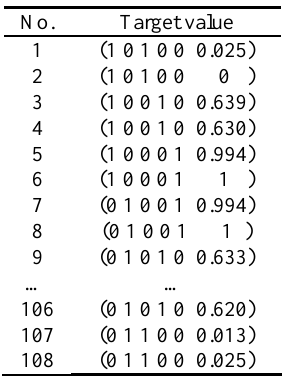
Table 2. Target values of testing samples